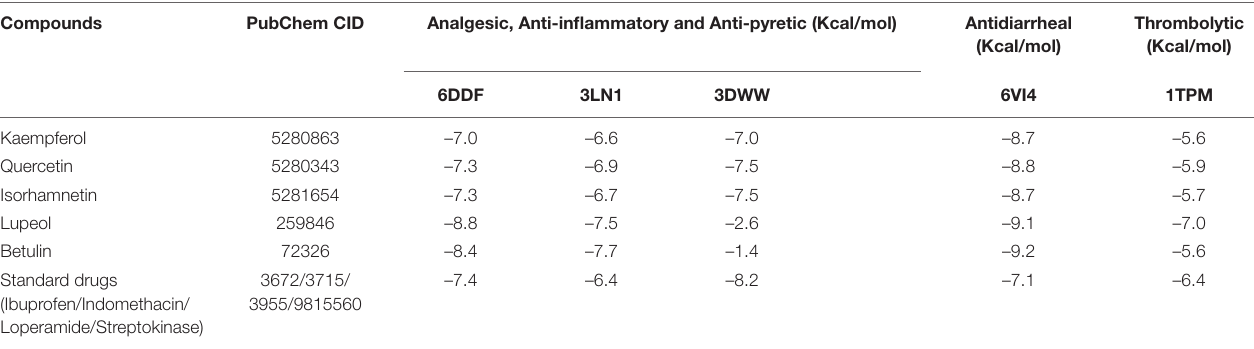
TABLE 5 | The docking score of screened phytochemical’s binding at the active site of the selected proteins.